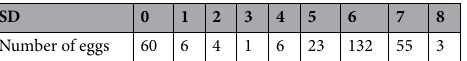
Table 2. SD of the collected 290